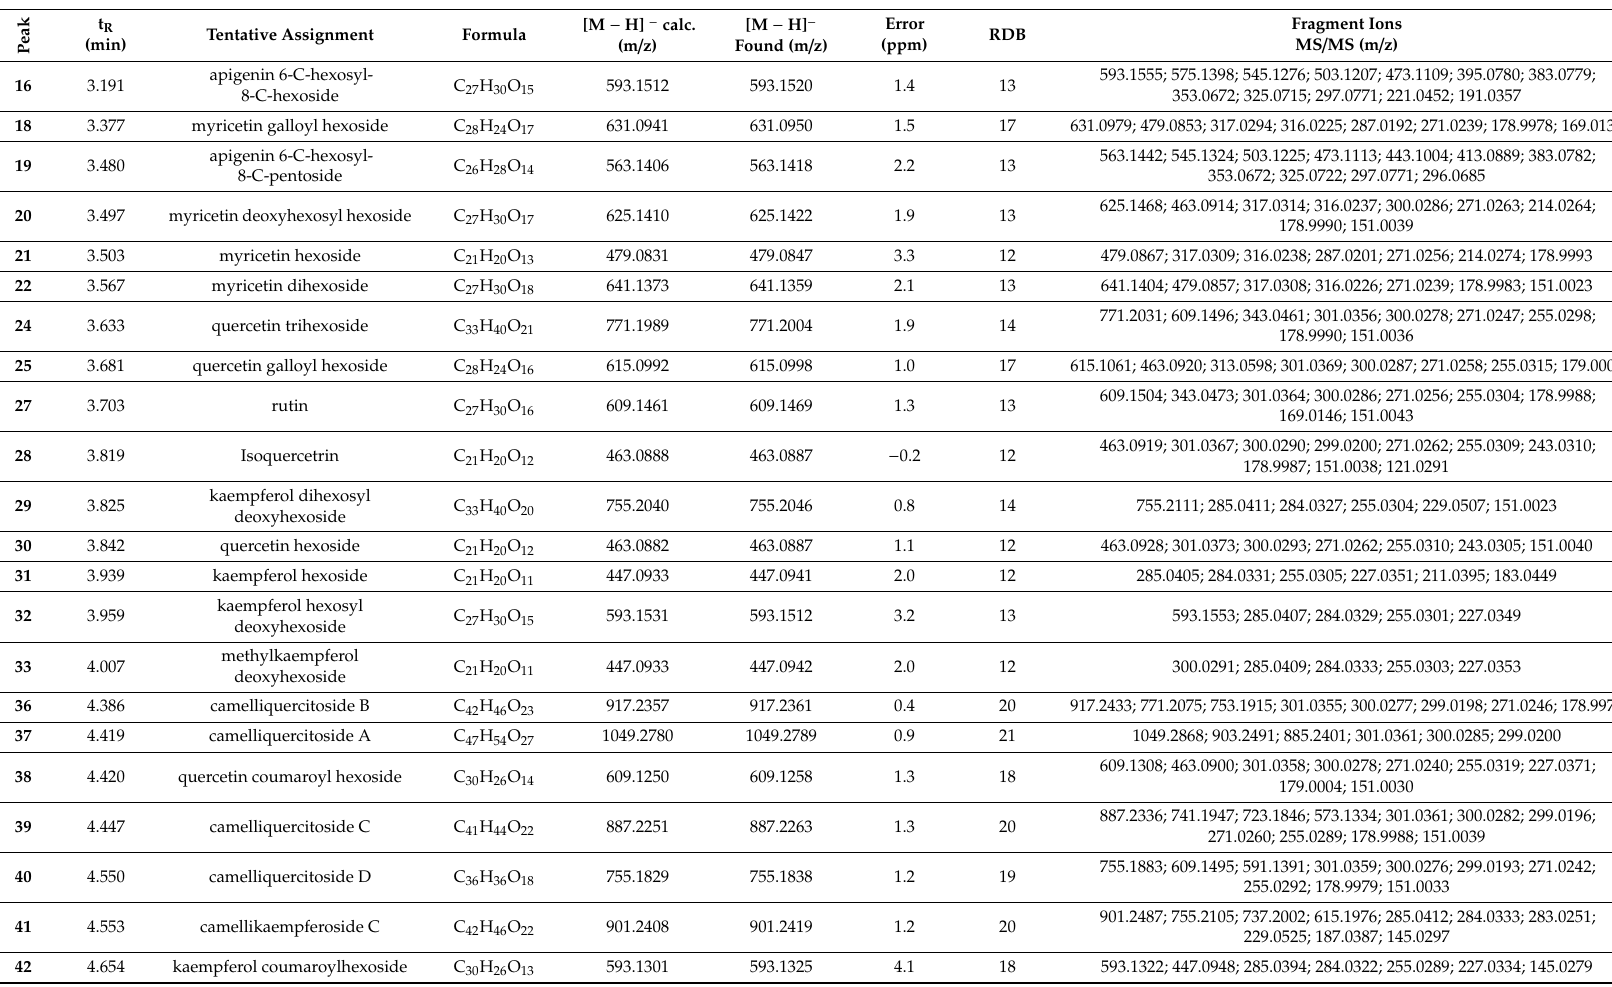
Table 3. TOF-MS and TOF-MS / MS of tentatively identified flavonol glycosides in investigated green tea extracts. Compounds are numbered based on their RT in the whole total ion current chromatogram. RT = Retention Time; RDB = Ring Double Bond equivalent